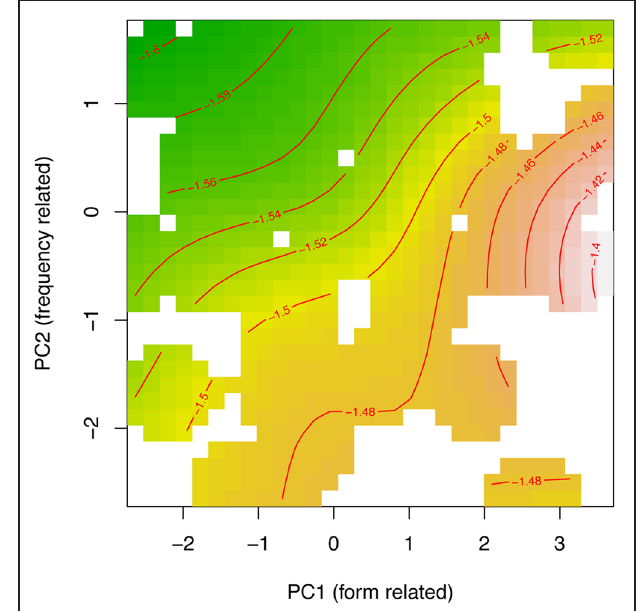
FIGURE 8 | Tensor product smooths for the non-linear interaction of the principal component for form-related neighboring words (PC1) and frequency of occurrence (PC2). Green indicates shorter response latencies, and yellow-to-brown indicates longer response latencies at 34 ms SOA.